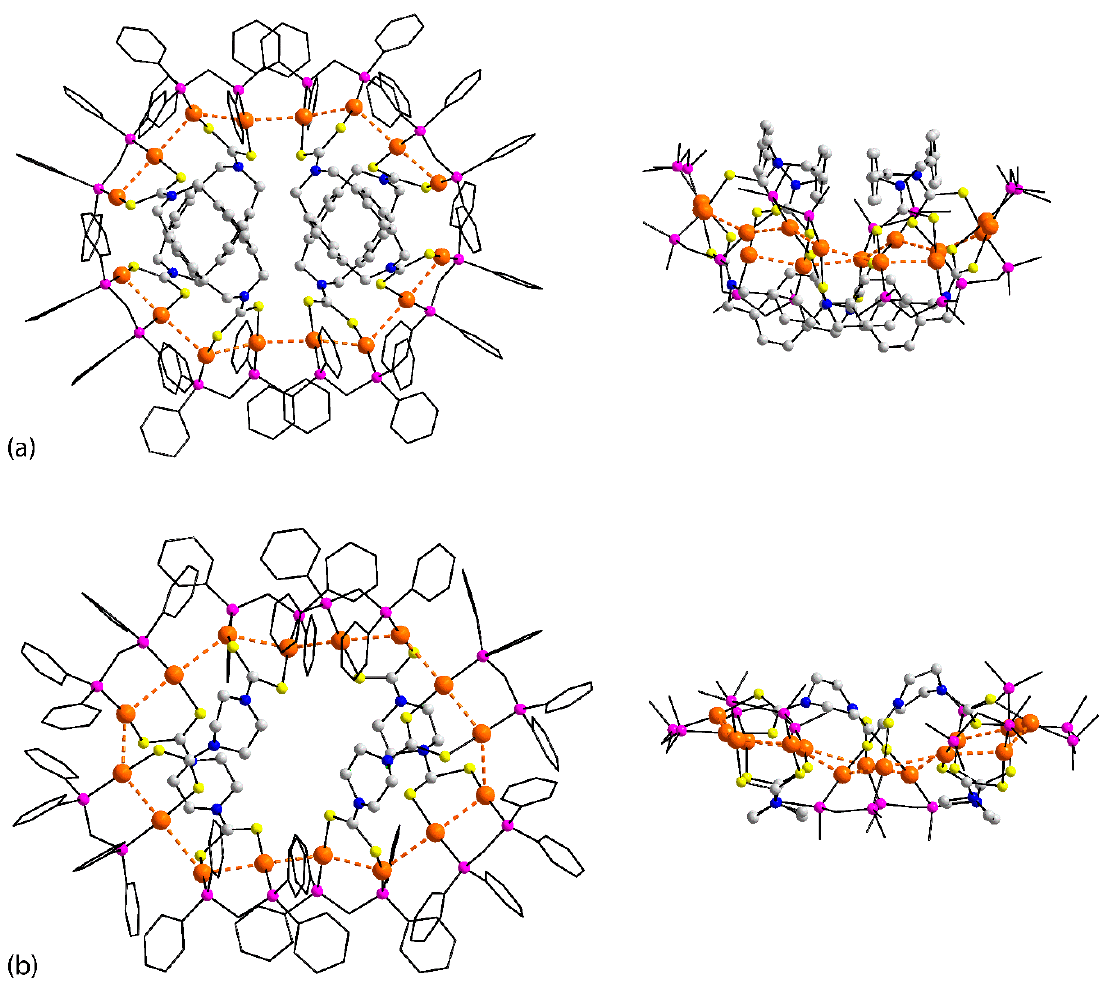
Figure 9. Molecular structures of ( a ) [Au 16 (L 15 ) 4 ] 8+ in the crystal of 36 and ( b ) [Au 16 (L 2 ) 4 ] 8+ in 37 , with simplified versions shown on the right-hand side.